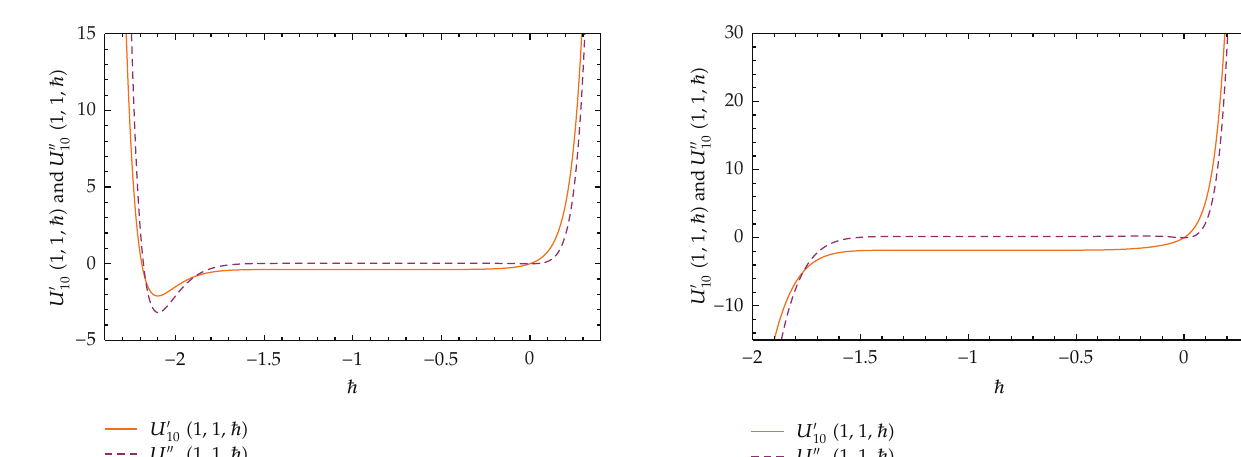
Figure 4: The ℎ curves of 𝑈 󸀠 10 (1,1, ℎ) and 𝑈 󸀠󸀠 10 (1,1, ℎ) for P - P column.